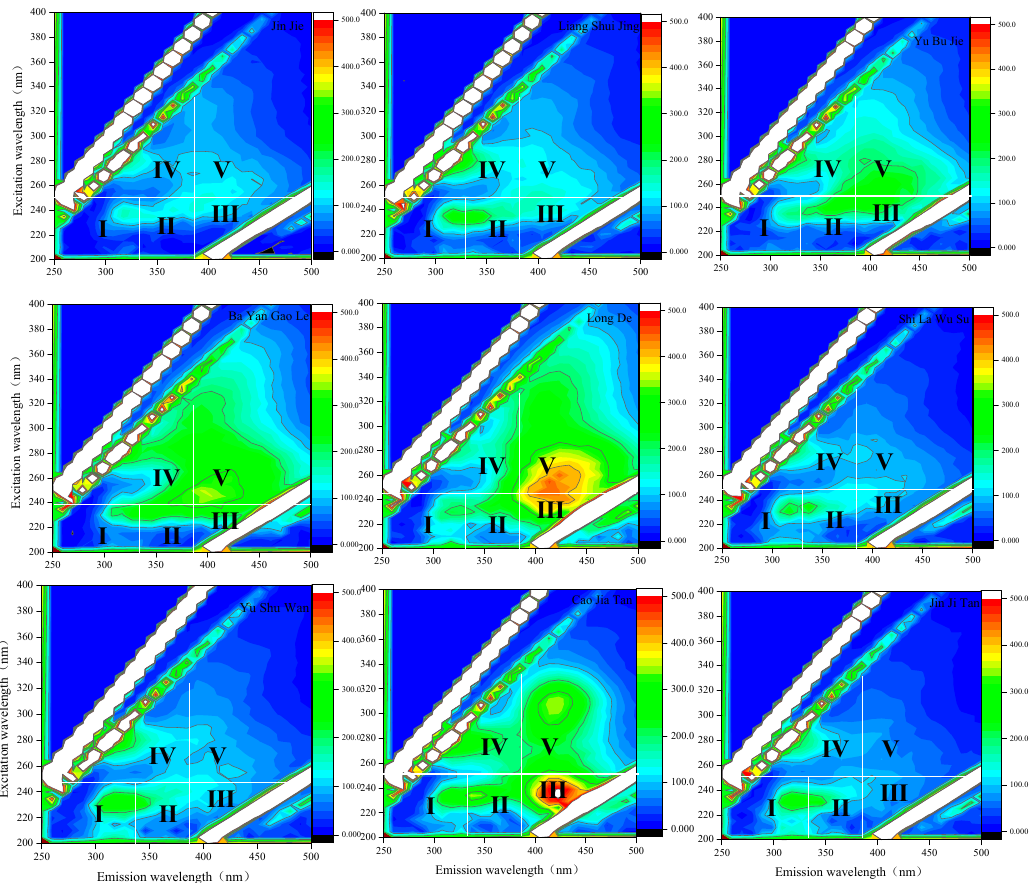
Figure 4. DOM distribution of the water samples from 15 coal mine water treatment stations.